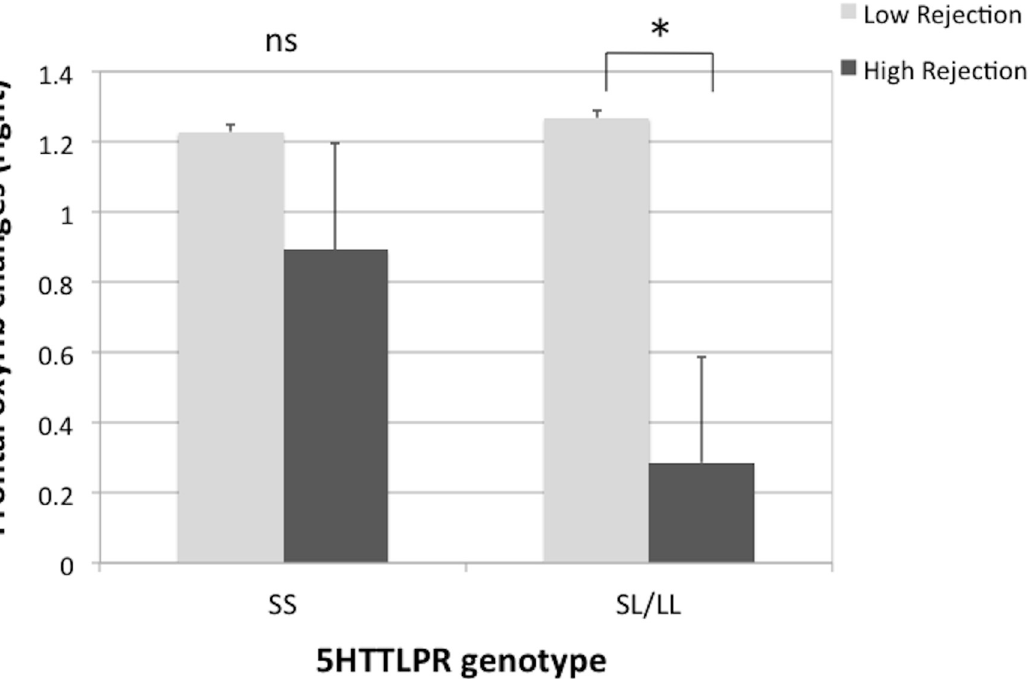
Fig 5. Comparisons of high/low maternal rejection in right frontal oxy-Hb changes during ambiguous facial expression task within the same genotype group. Note: * p < .05.